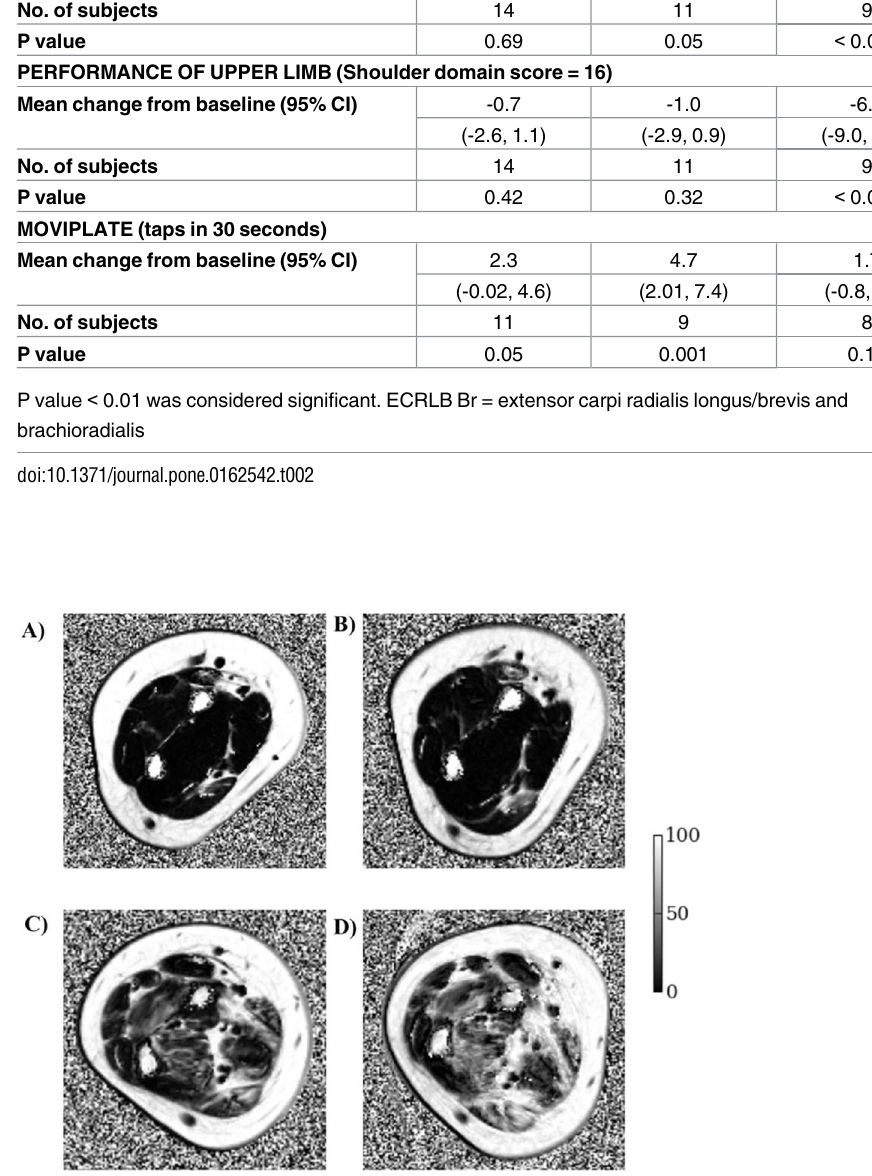
Fig 2. 3-point Dixon fat-fraction (f.f.) maps of dominant forearm central slice at baseline (left images) and 12 months (right images). Top: 13 y.o. DMD, non-ambulant for 40 months, and on daily steroids. Overall mean f.f. at baseline = 7.6% (A) and 12 months = 9.7% (B). Bottom: 11 y.o. DMD, non-ambulant for 14 months, not on steroid therapy. Mean f.f. at baseline = 30.7% (C) and 12 months = 43.3% (D). (Grey-level bars represent f.f. from 0 to